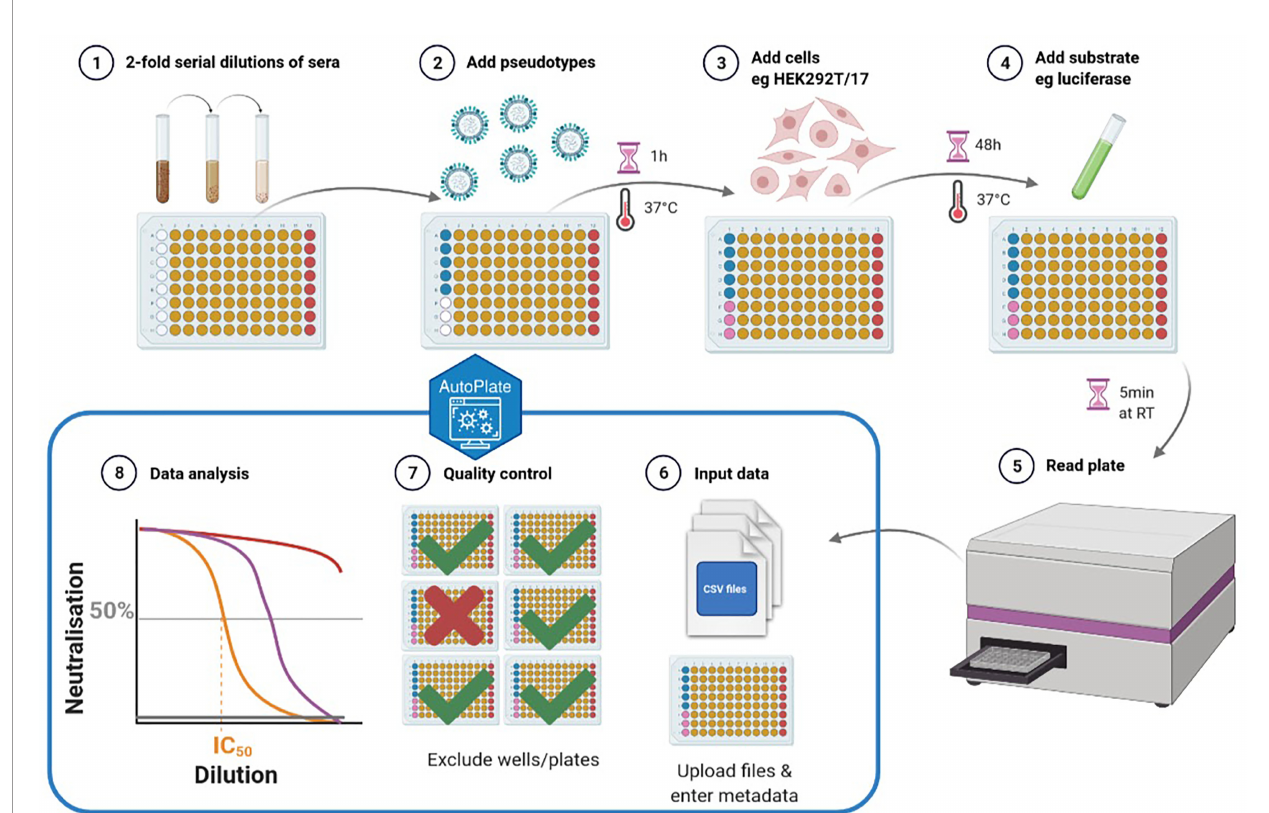
FIGURE 1 | Schematic representation of the pseudotype neutralisation (pMN) assay. Steps 1-5 show the lab protocol for the pMN assay and steps 6-8 show the computational analysis using AutoPlate. The plate layout for the well types can be seen where the sera (type “ x ” ) are shown in yellow, antibody positive control (type “ m ” ) shown in red, virus (type “ v ” ) shown in blue and cells (type “ c ” ) shown in pink (created with BioRender)